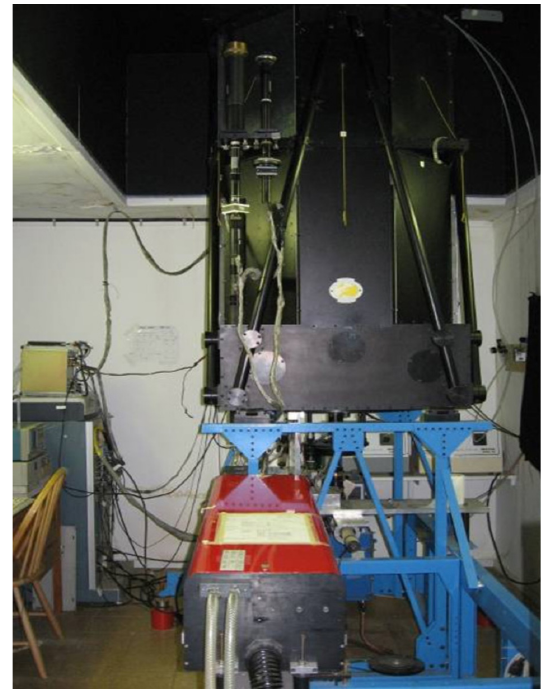
Figure 2. The lidar installed at